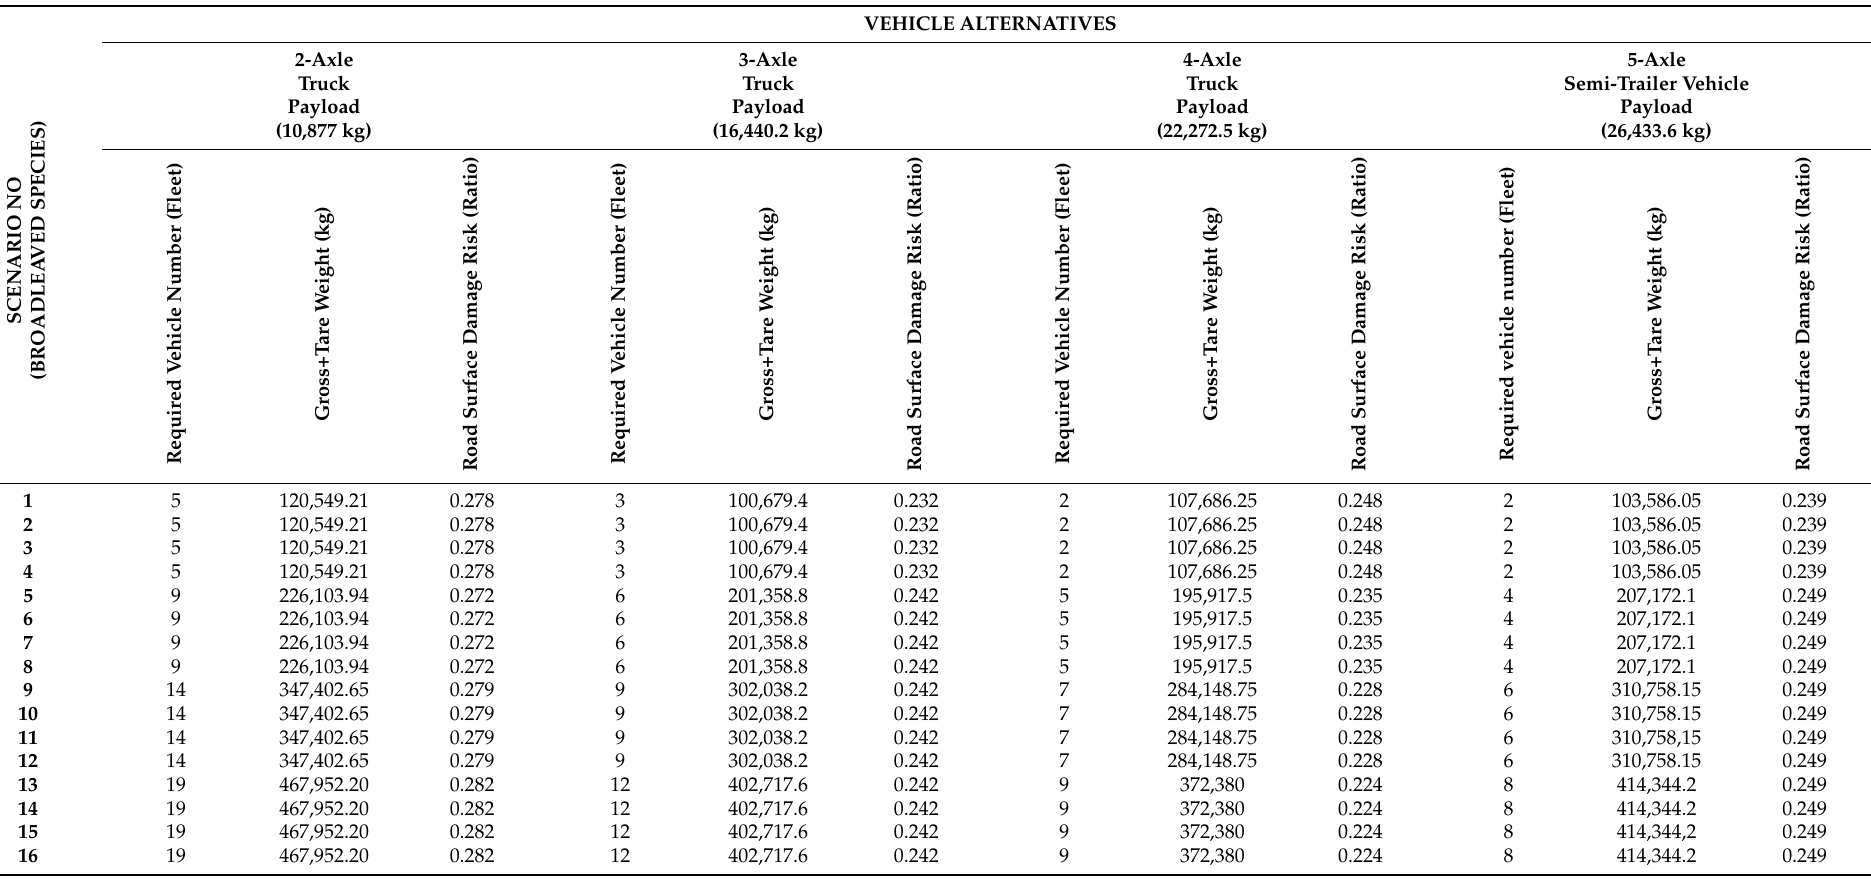
Table 20. Road surface risk values in terms of broadleaved species for vehicle